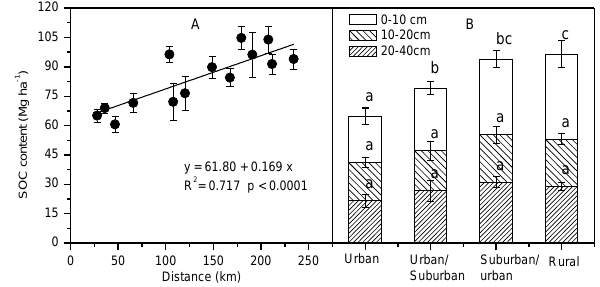
Fig. 2. Change in SOC content in the top 40cm soil. (A) correla- Fig 2. Change of SOC content in the top 40 cm soil. (A) correlation analysis of bulk SOC content 490 tion analysis of bulk SOC content (in the 0–10cm, 10–20cm, and (in 0-10 cm, 10-20 cm, and 20-40 cm soil layer) and the distance from urban to rural; (B) 491 20–40cm soil layers) and the distance from urban to rural; (B) com- comparisons of SOC content among four urbanization gradient classes. Error bars indicate ± 1 S.E. 492 parisons of SOC content among four urbanization gradient classes. (N = 3 for urban and rural, N=4 for urban/suburban and suburban/rural). Different letters denote 493 Error bars indicate ± 1S. E. ( N = 3 for urban and rural, N = 4 for significant difference ( P ≤ 0.05) between gradient classes (SNK test). 494 urban/suburban and suburban/rural). Different letters denote signif- icant differences ( P ≤ 0.05) between gradient classes (SNK